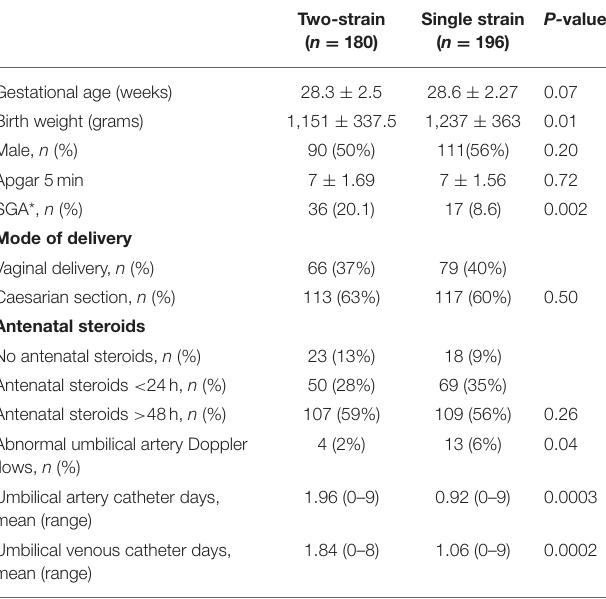
TABLE 1 | Clinical characteristics of preterm infants in the single vs. two-strain probiotic group.